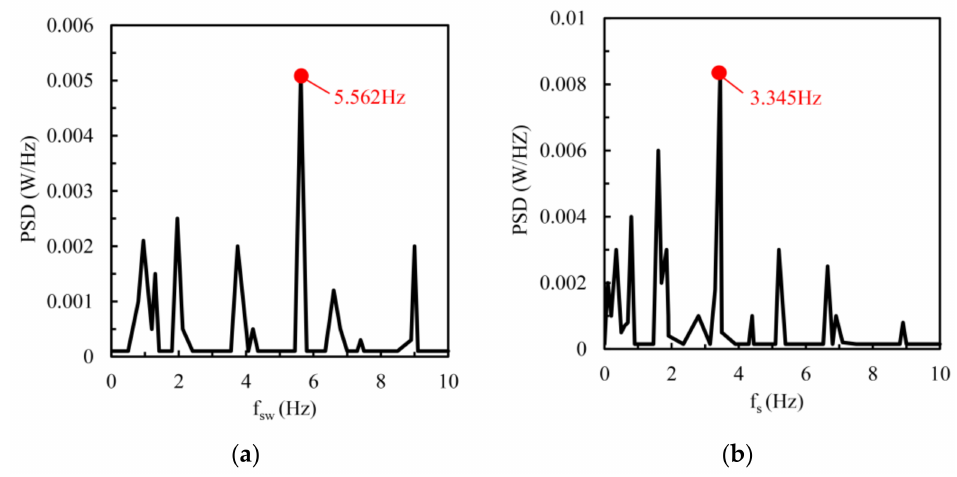
Figure 20. VIV frequency spectrum (FFT): ( a ) small-scale O-specimen; ( b ) small-scale